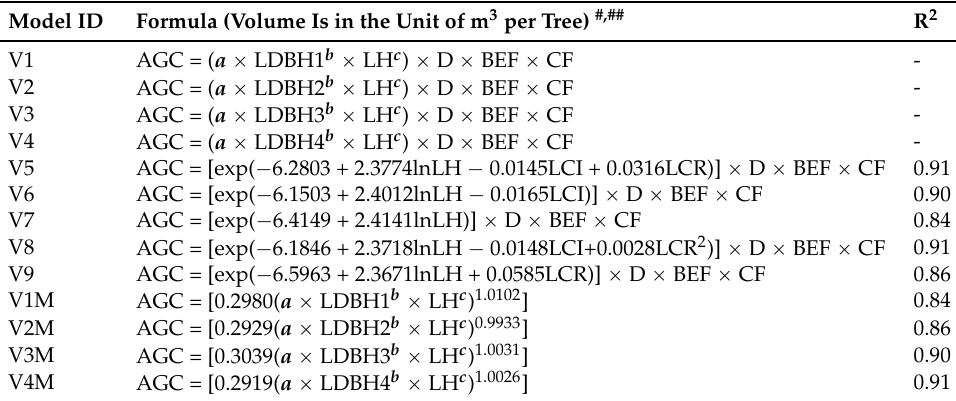
Table 2. Volume-based tree-level AGC models using LiDAR-derived tree